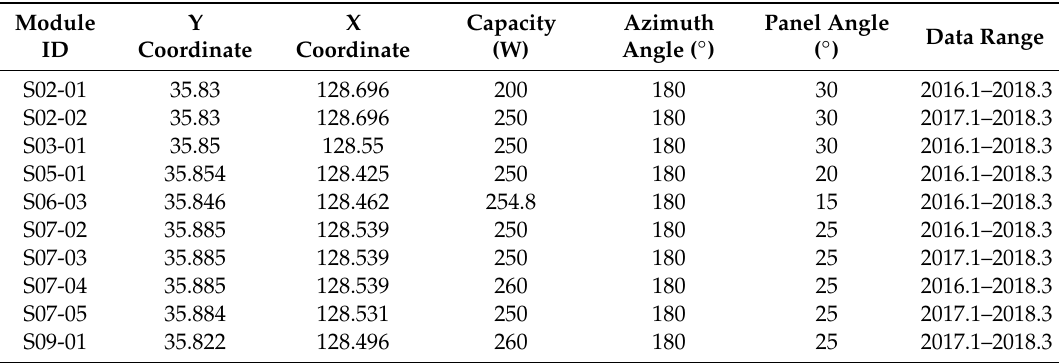
Table 1. Solar power generation